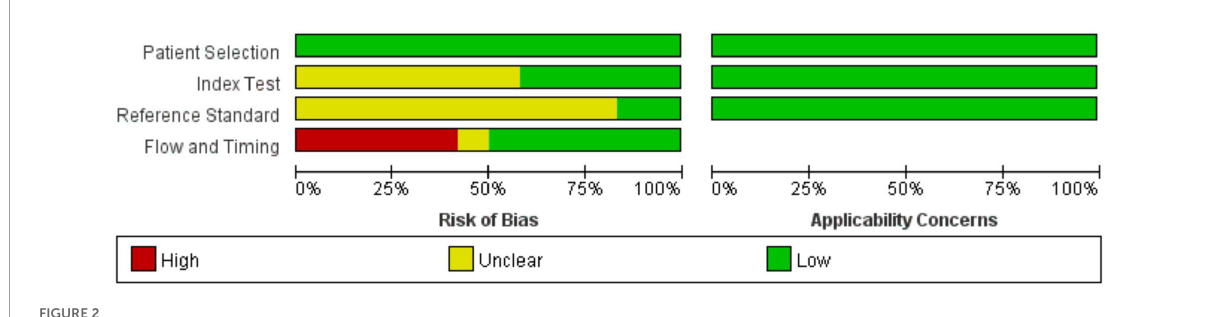
FIGURE2 QUADAS-2 quality evaluation of literature.